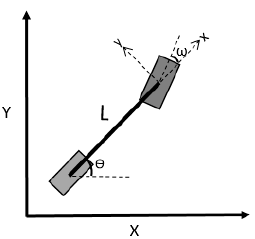
Figure 1. The simplified two-wheel vehicle kinematic model.